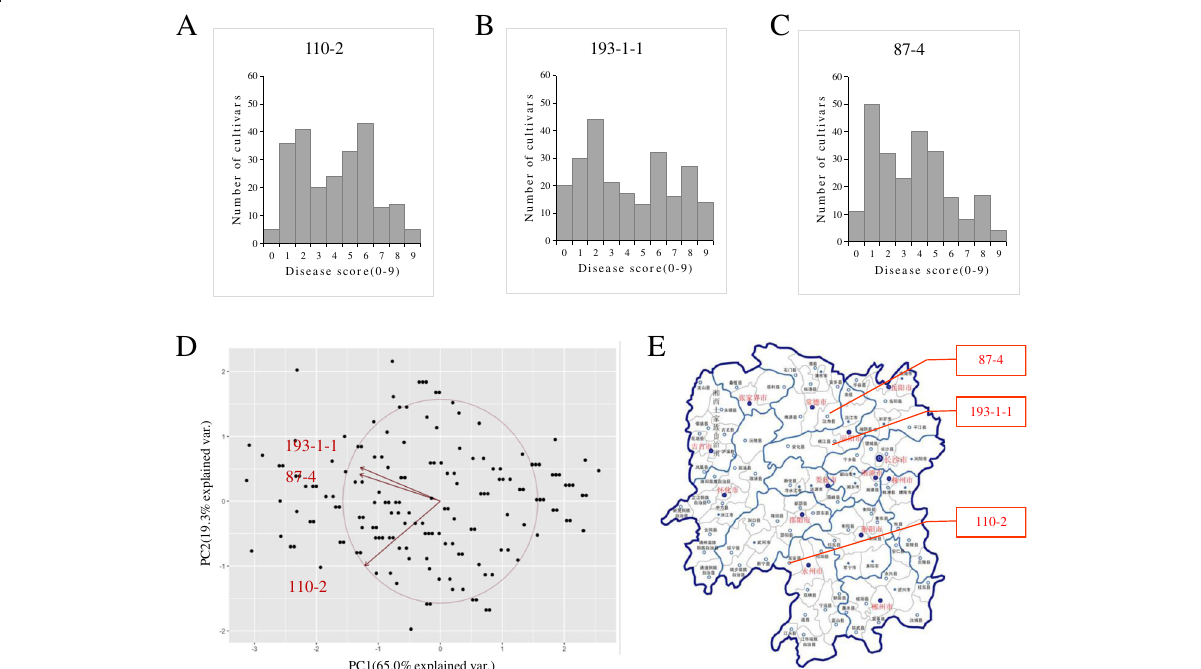
Fig. 1 The information of three M. oryzae isolates and blast disease scores of the 234 RDP1 cultivars. a - c The distribution of disease scores of the 234 RDP1 cultivars against isolates 110-2, 193-1-1 and 87-4. d PCA of resistance phenotypes of the 234 RDP1 cultivars to the three isolates. e Geographic distribution of three M. oryzae isolates in Hunan Province